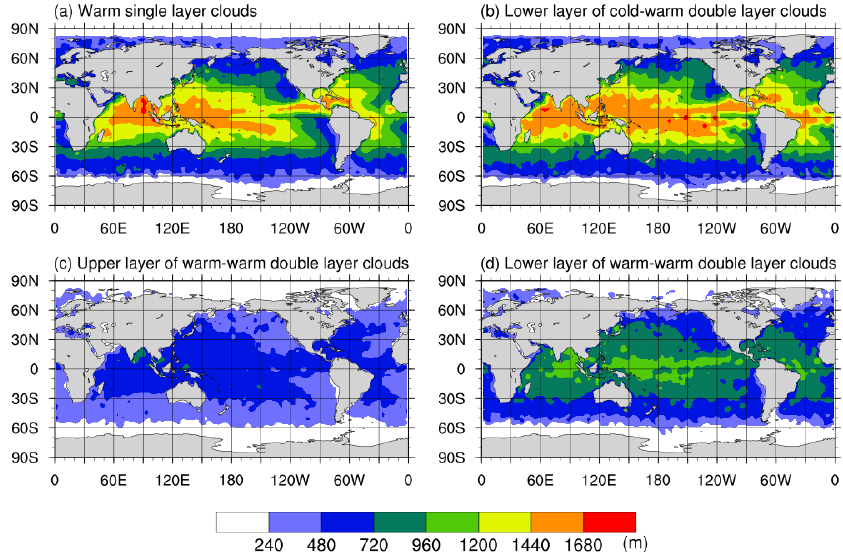
Figure 7. Global distribution of cloud geometric thickness for warm single layer clouds ( a ), lower layer of cold-warm double layer clouds ( b ), upper layer of warm-warm double layer clouds ( c ), and lower layer of warm-warm double layer clouds ( d ).